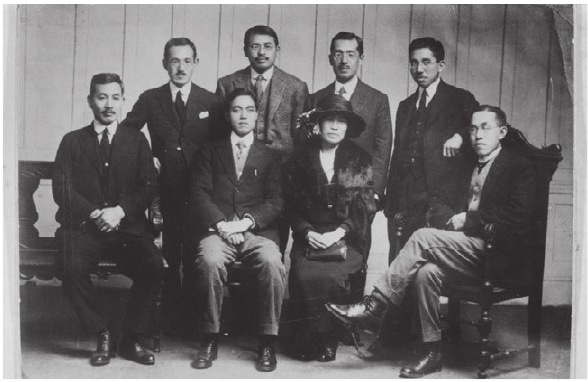
Figure 4. (Ku-6018). Taisho 12 January 26 (1923) in Oxford. Kuro- da Chika and Japanese students. 6